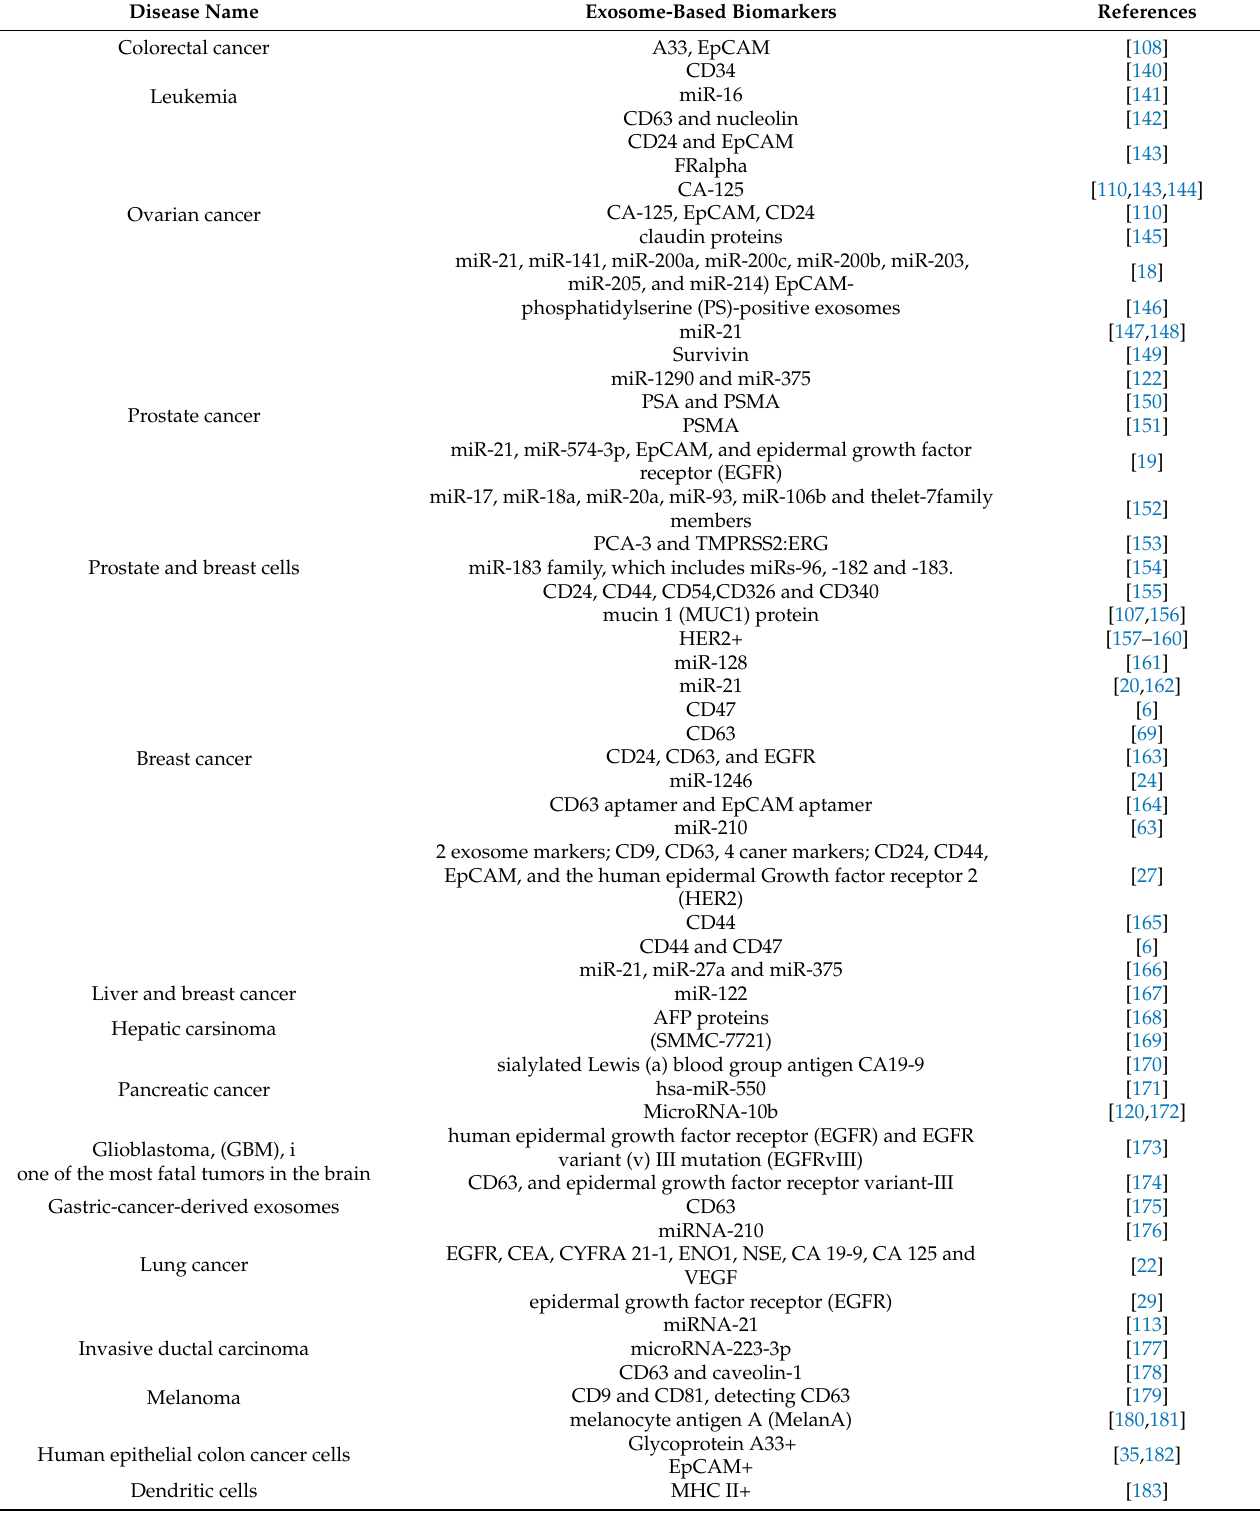
Table 4. Biomarkers of specific proteins in exosomes according to disease